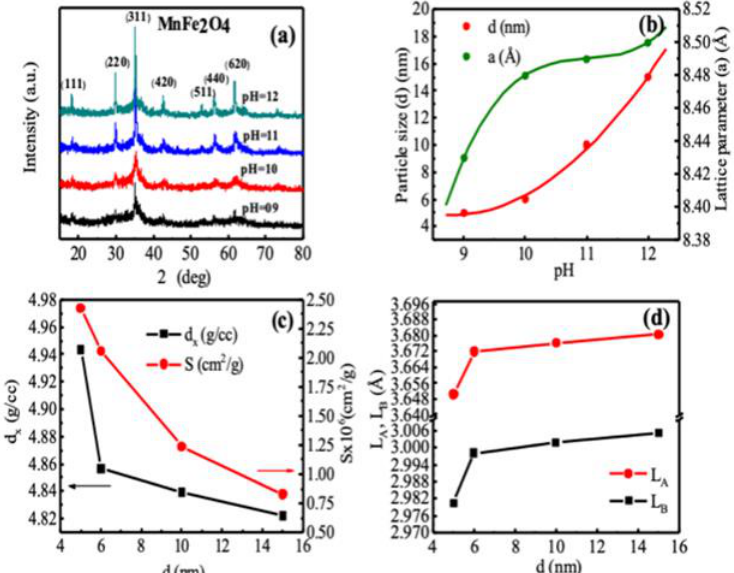
Figure 1. XRD studies of as-dried MnFe 2 O 4 nanoparticles at different pH. ( a ) XRD patterns of the samples synthesized at pH of 9, 10, 11, and 12, ( b ) pH dependence particle size (d) and lattice parameter (a), ( c ) nanoparticle size dependence of X-ray density (d x ) and specific surface area (S), ( d ) nanoparticle size dependence of hopping length (L) for tetrahedral (A) and octahedral (B) site.